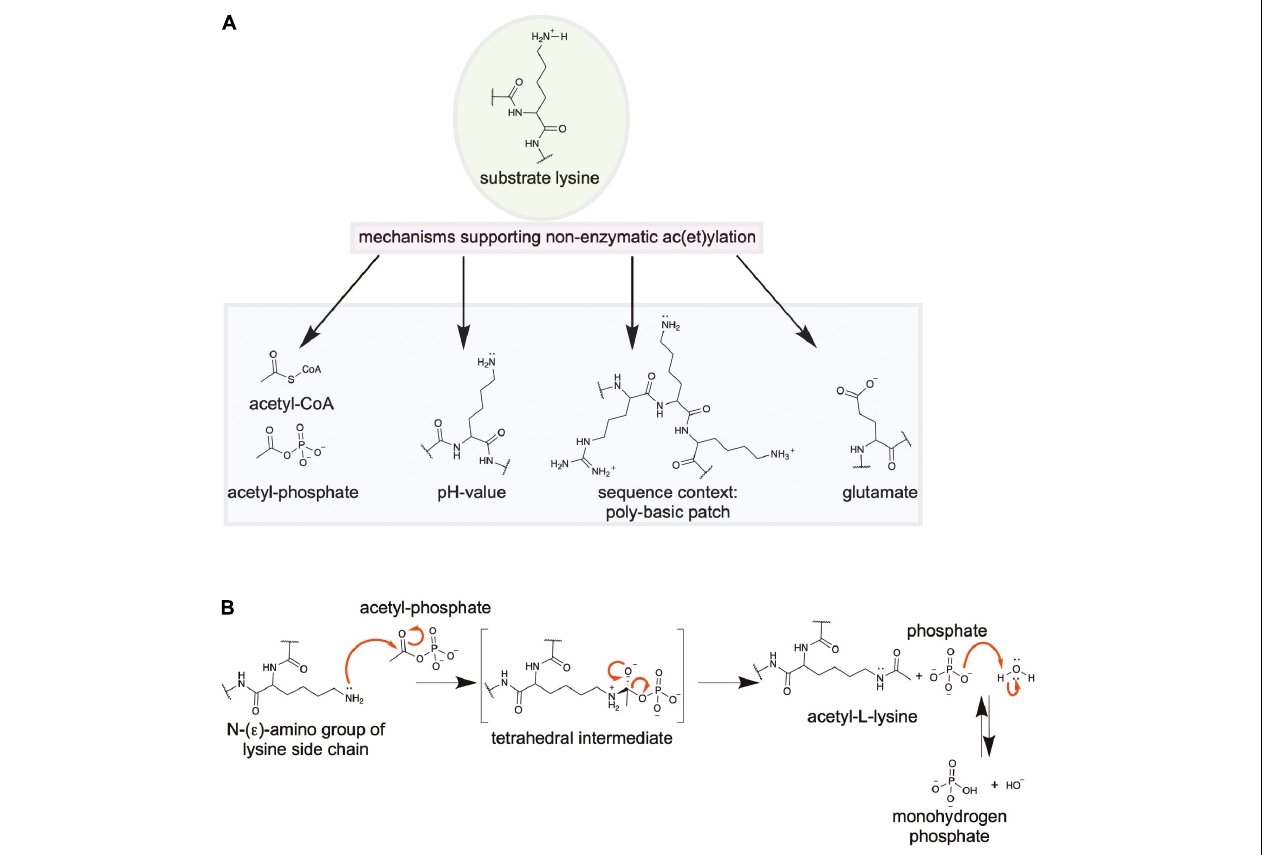
FIGURE 7 | Non-enzymatic N-( ε )-lysine and/or N-( α )-N-terminal ac(et)ylation. (A) Several mechanisms contribute to the efficiency of non-enzymatic acetylation. The high energy ac(et)yl-CoA thioesters and the mixed anhydride acetyl-phosphate are very reactive molecules. Upon increase of the intracellular concentrations the level of systemic lysine and/or N-terminal ac(et)ylation is increased. Furthermore, an alkaline pH-value supports non-enzymatic ac(et)ylation as it affects the protonation state of the ε - and α -amino groups. Under more alkaline conditions the amino groups are in a more deprotonated state increasing their nucleophilicity prone for non-enzymatic ac(et)ylation. Moreover, the sequence context of the lysine side chain affects its reactivity. The presence of the substrate lysine side chain in poly-basic patches containing several basic residues such as arginine and lysine lowers the lysine side chains pK a value resulting in a more reactive, deprotonated state under physiological pH. Finally, spatial vicinity and proper orientation of the substrate amino group to an acidic residue such as glutamate can favor its deprotonation increasing its nucleophilicity. (B) Reaction mechanism for non-enzymatic ac(et)ylation of substrate amino groups. In bacteria most of non-enzymatic acetylation is due to acetyl-phosphate. However, also ac(et)yl-CoA contributes to non-enzymatic ac(et)ylation in bacteria. Shown is the reaction of non-enzymatic lysine acetylation by acetyl-phosphate. A tetrahedral intermediate is formed following the nucleophilic attack of the deprotonated lysine side chain to the electrophilic carbonyl carbon of acetyl-phosphate. This intermediate decomposes to form ac(et)yl-lysine and CoA (figure redrawn and modified from Ali et al. (2018) and Blasl et al. (2021)].